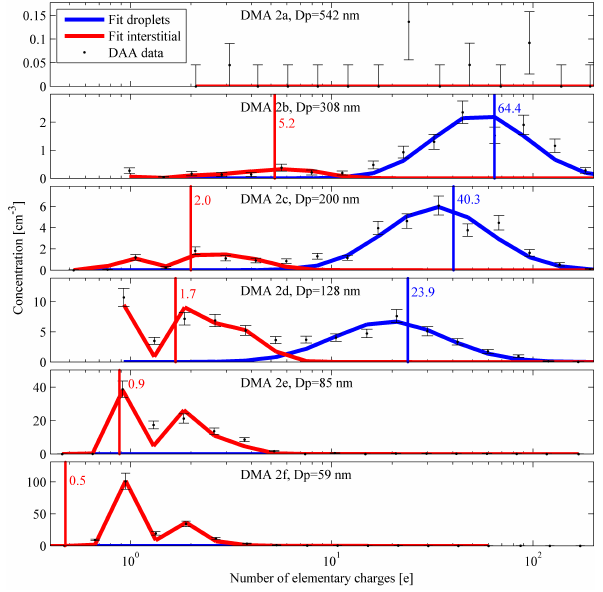
Fig. 2. Example of results obtained from data collected at Mt. Brocken, one run from 31 August 2010, 00:53–01:03UTC. The panels show charge distribution data from the DMA 2a–f, includ- ing the standard error for Poisson counting of the raw counts. In this example, one or two fits were performed for each DMA 2a– the top panel, showing the results from DMA 2a for the largest dry particle diameter measured in this run, and in the two lowest pan- els, showing the results for the two smallest dry particle diameters measures (DMA 2e and 2f), there were insufficient particles and droplets to allow for a fit. Note the varying scale on the y